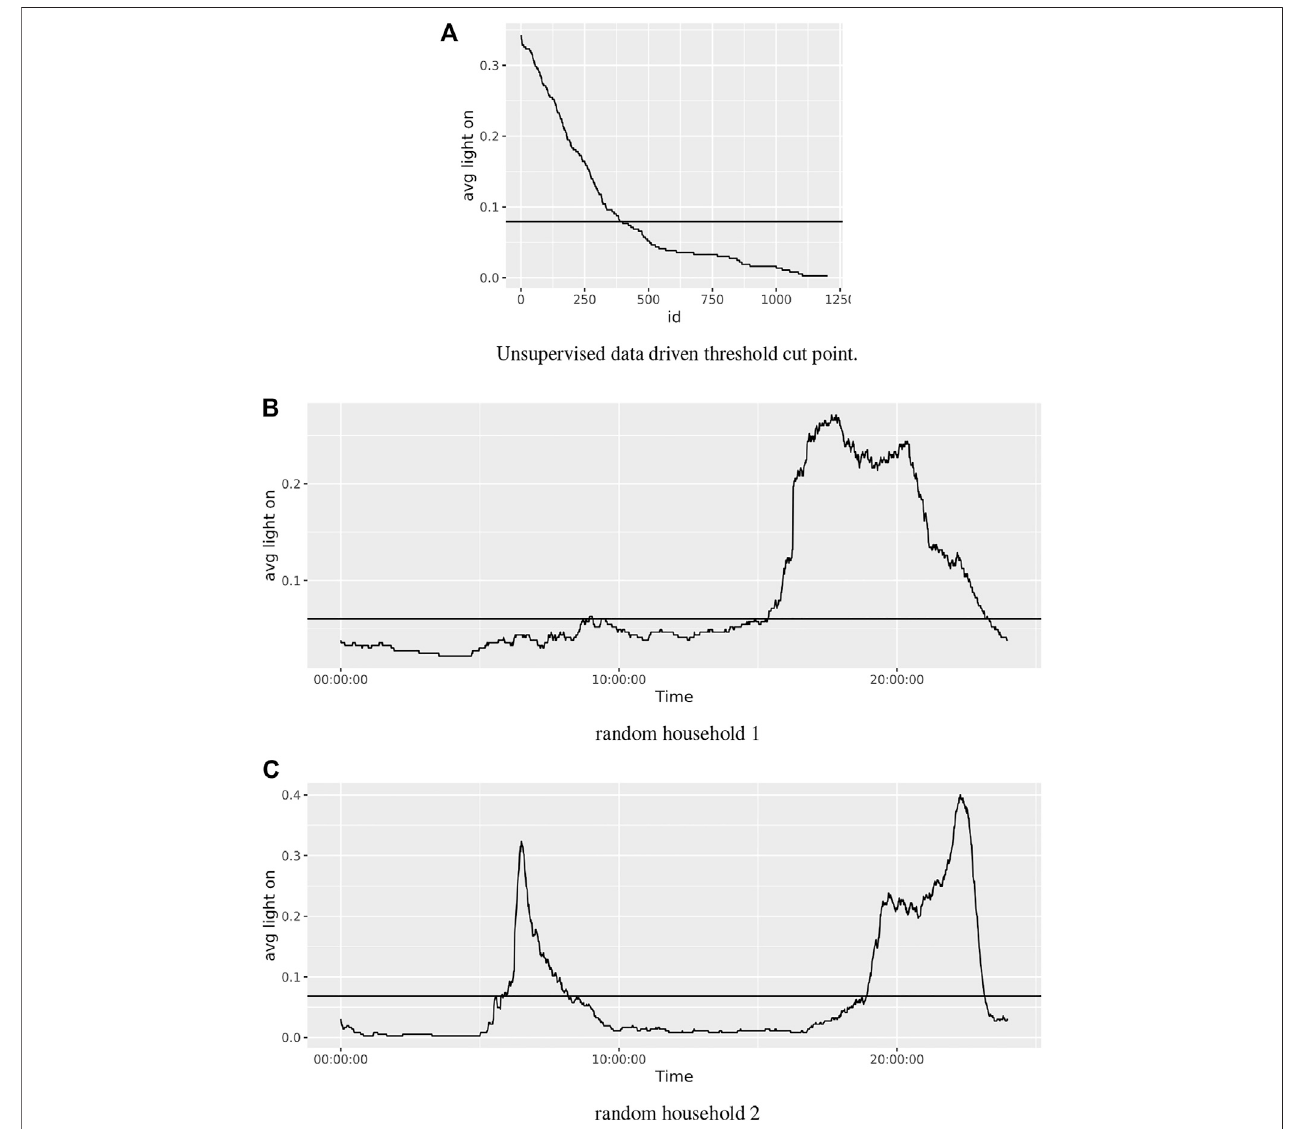
FIGURE 1 | Usage distribution and cutoff